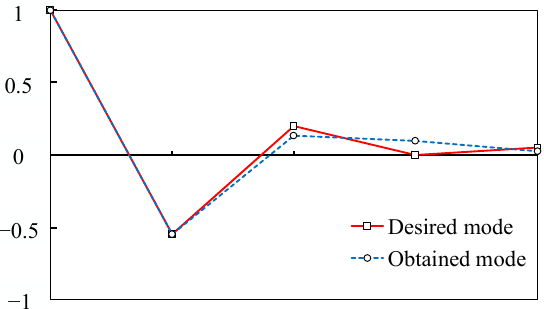
Figure 20. Comparison of desired and attained modes: 39 Hz.